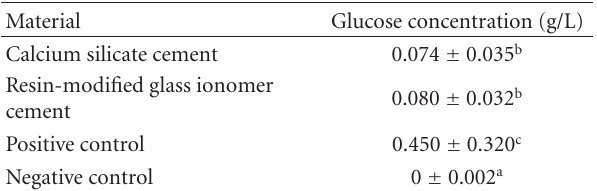
Table 3: Glucose concentration in the receiving medium after 1 h di ff usion through the gingival margin of open-sandwich restora- tions filled with a calcium silicate-cement or a resin-modified glass ionomer cement. A statistically significant di ff erence was found among the four groups. The groups with the same superscript letter were not statistically di ff